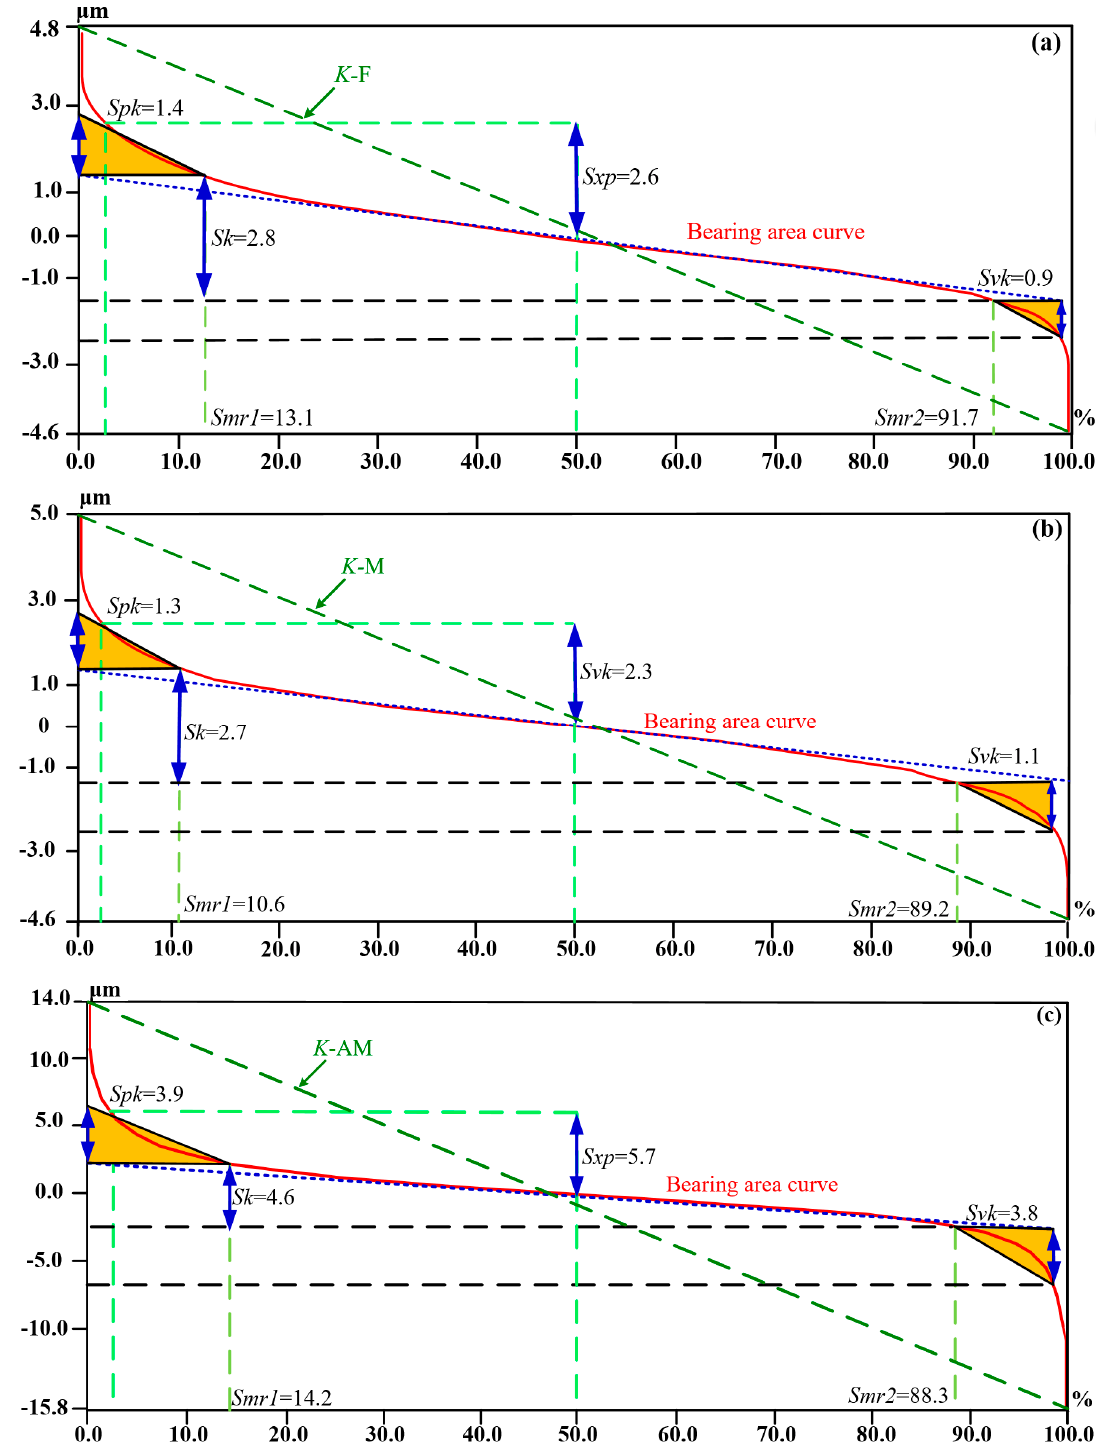
Figure 6. Bearing area curves of ( a ) flat; ( b ) micro-textured; ( c ) anodizing micro-textured samples. Table 5. Nomenclature and definition of bearing area ratio parameters.